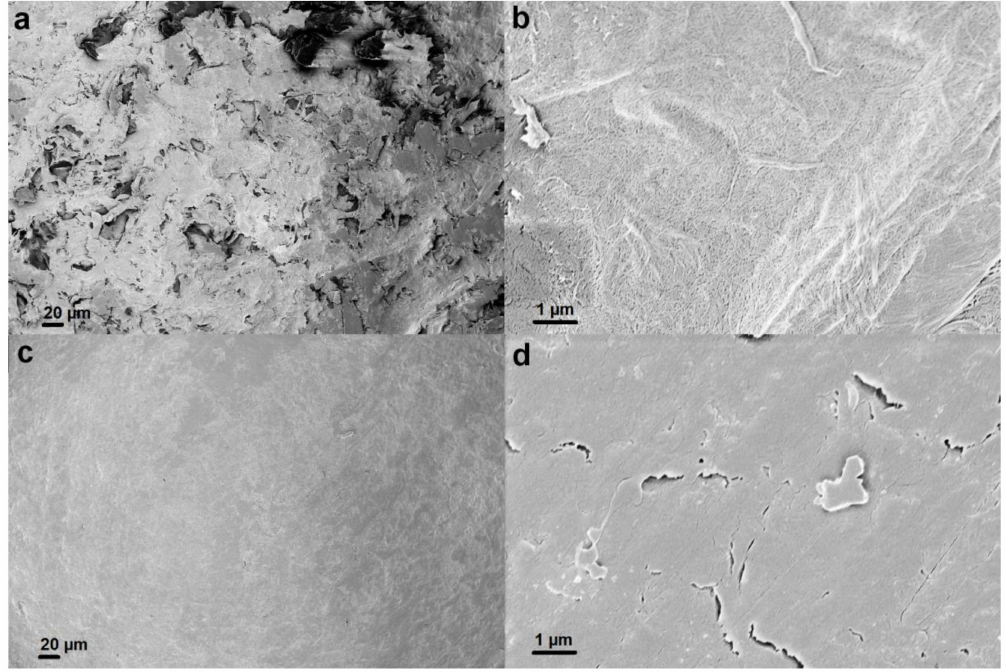
Figure 2. Scanning electron microscopy (SEM) images of EPT-CNF nanopapers at a magnification of ( a ) 250 × and ( b ) 10,000 × compared to PT-CNF nanopapers at a magnification of ( c ) 250 × and ( d ) 10,000 ×